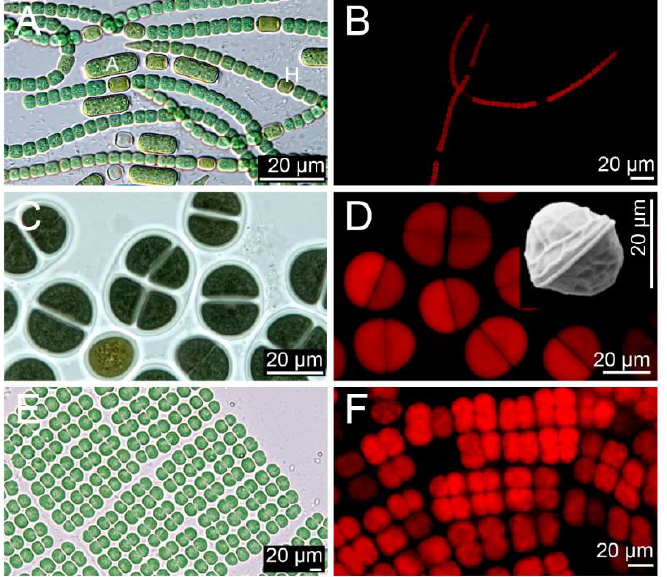
Figure 4. Light microscopy (LM), fluorescence, and scanning electron microscopy (SEM) images of cultured cyanobacteria strains. ( A ) Anabaena sp. strain TIOX110 showing heterocyst (H) and akinetes (A). ( B ) Anabaena sp. showing the chlorophyll autofluorescence. ( C ) Chroococcus sp. TIOX101. ( D ) Chroococcus sp. showing the chlorophyll autofluorescence and SEM of the cell. ( E ) Merismopedia sp. TIOX109. ( F ) Merismopedia sp. showing the chlorophyll